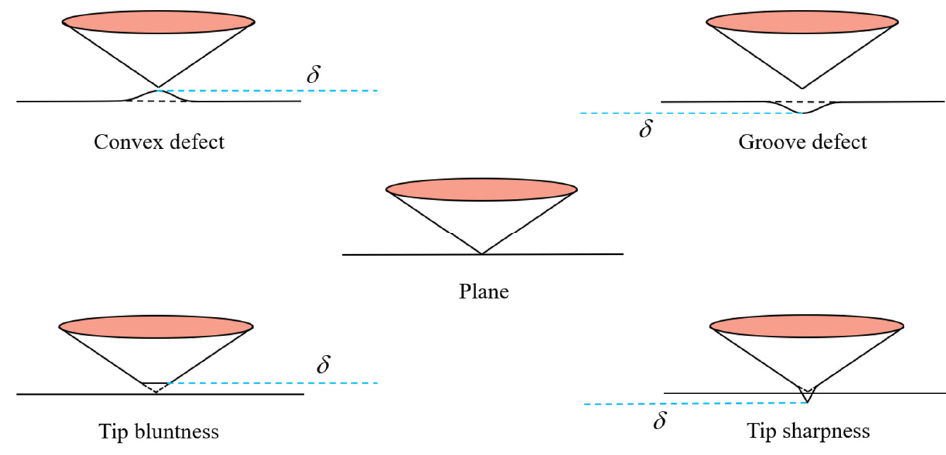
Figure 6. Different kinds of contacts between indenter and sample. The load–depth curves are obtained by measuring the relationships between reaction force and indenter displacement during loading and unloading, as shown in Figure